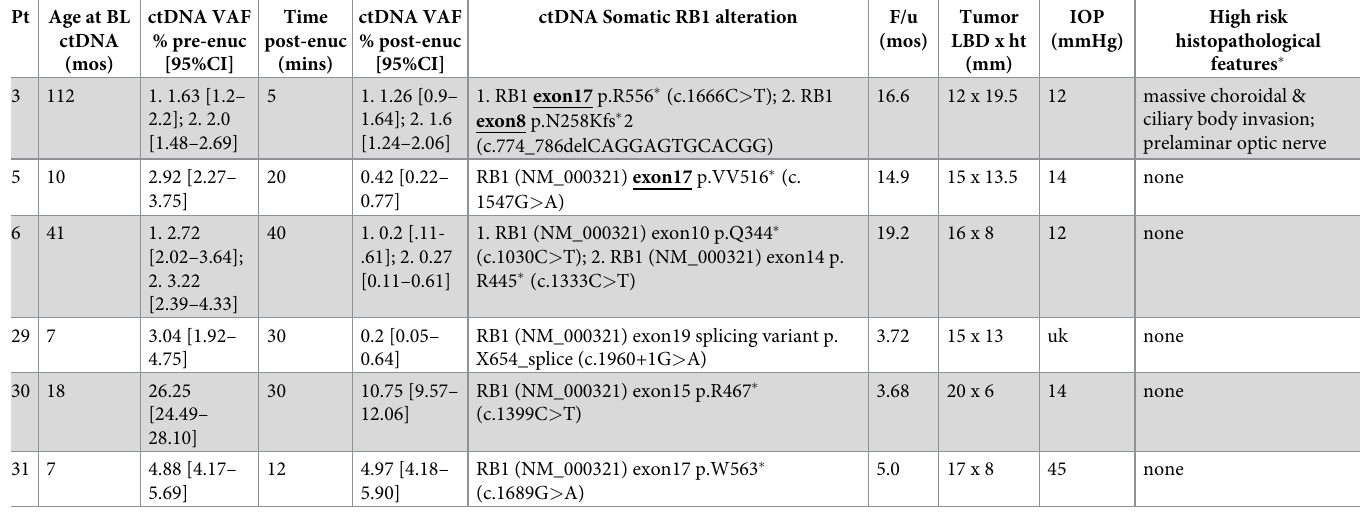
BL = baseline, mos = months, ctDNA = circulating tumor DNA, post-enuc = post-enucleation, mins = minutes, VAF = variant allele frequency, 95%CI = 95% confidence interval, LBD = largest basal diameter, ht = height, IOP = intraocular pressure.